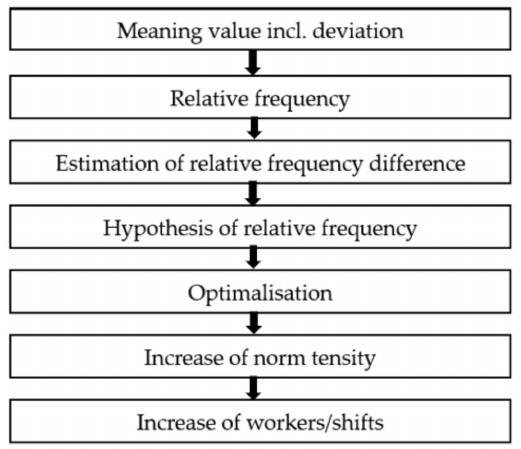
Figure 2. Methodology of the use of statistical methods.